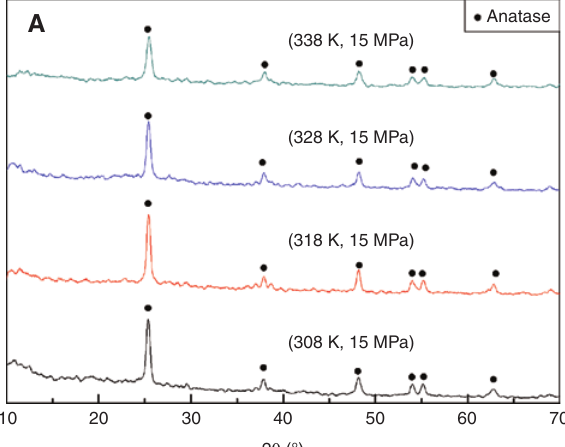
Figure 2: The X-ray diffraction results of the TiO lites before and after calcination. (A) Before calcination, (B) after